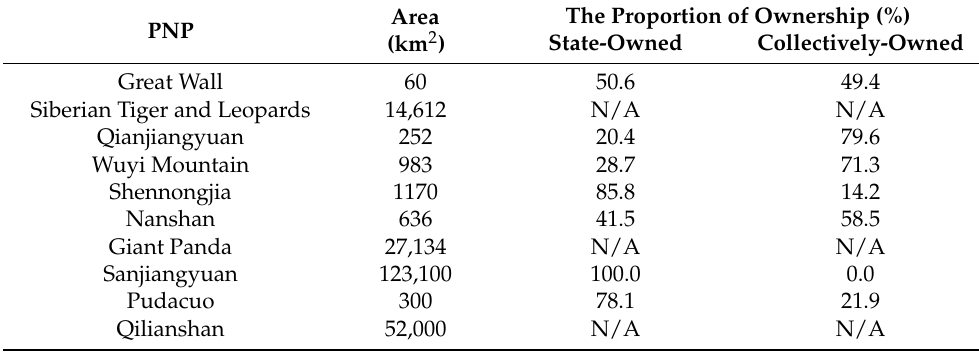
Table 1. China’s PNPs’ proportion of land ownership (Modified from